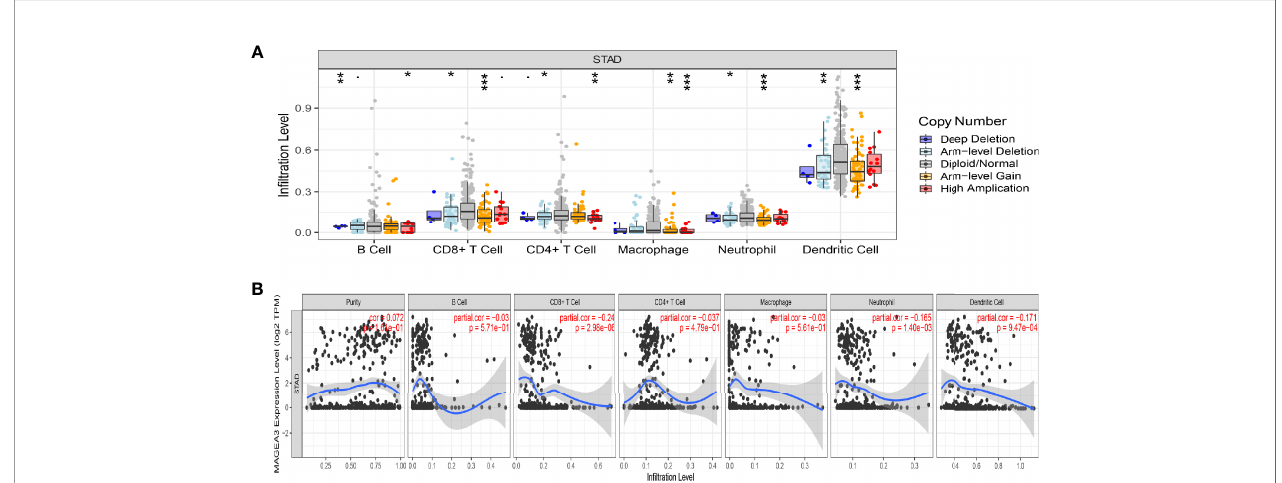
FIGURE 5 | Correlation analysis of MAGEA3 expression and immune in fi ltration in GC by TIMER. (A) Association between MAGEA3 gene copy number and immune cell in fi ltration levels in GC cohorts. (B) Correlation of MAGEA3 expression with immune in fi ltration level in GC. *p < 0.05; **p < 0.01; ***p <